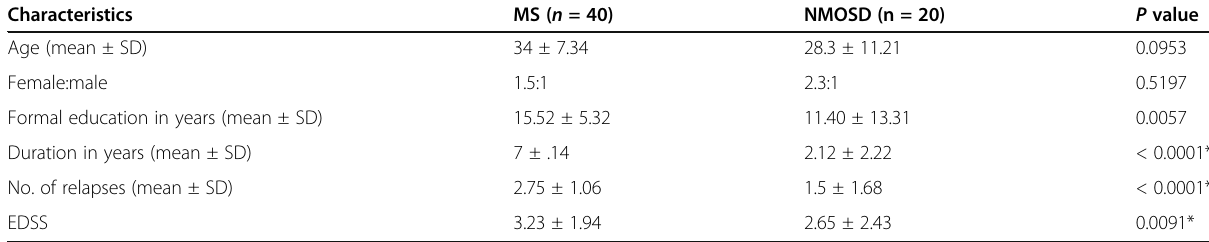
Table 1 General characteristics of NMOSD and MS patients Characteristics